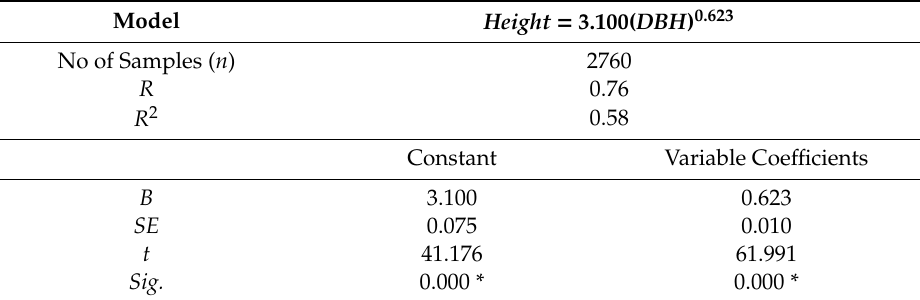
Table 2. Regression Statistics of the Height Estimation Model.